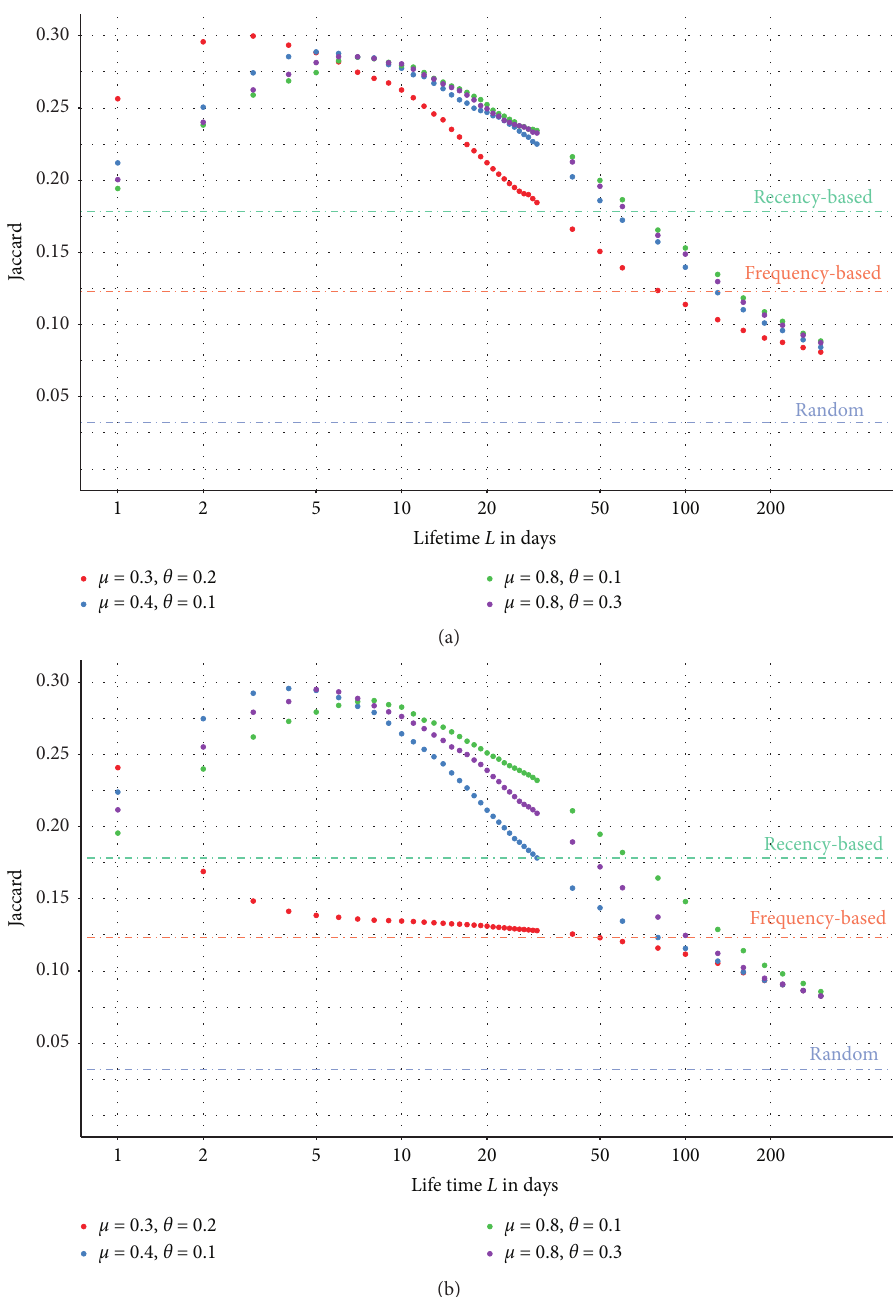
Figure 4: The plot of the Jaccard metric as a function of lifetime L . The metric measures the overlap between the two sets of peers, one identified by CogSNet and the other listed by students in the survey. These plots are compared to the results achieved by the three baseline models: recency-based with the best results obtained with the number of recent events set to 400, frequency-based, and random. The results are plotted for the CogSNet running with various parameters for (a) exponential and (b) power forgetting